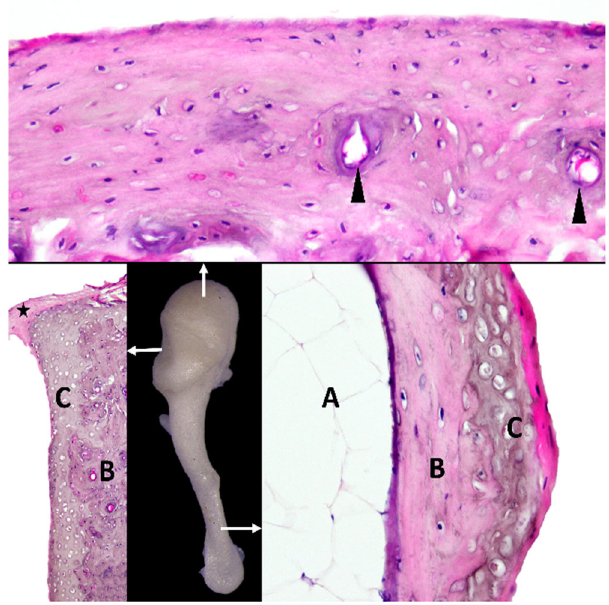
Figure 2. Histological aspects of malleus. Arrows indicate areas selected for histology. A—marrow cavity with adipocytes; B—subchondral compact bone; C—hyaline cartilage; arrowheads—blood vessels; star—incudomalleolar joint capsule with dense regular connective tissue.